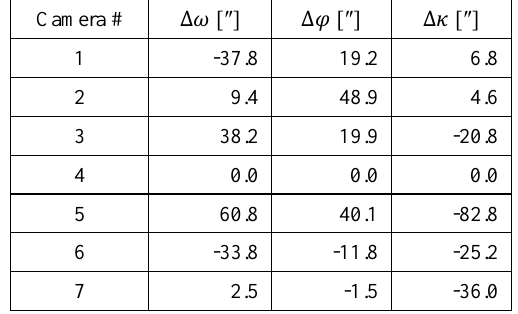
Table 14. Differences in the rotational components of the ROPs between the single-epoch minor calibration and the full major